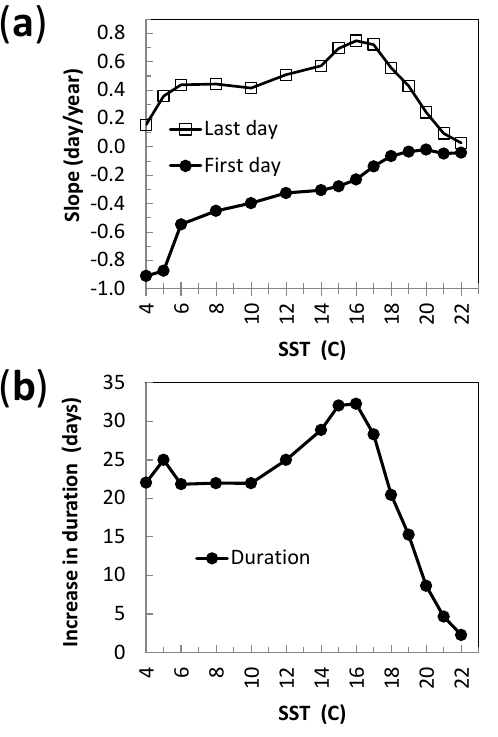
Figure 5. (a) Rate of change (dayyear − 1 ) in the day of year when a certain SST level is first reached (DFSST, filled circles) and when a certain SST level is last reached in a season (DLSST, open squares) for the Baltic Sea (area indicated in Fig. 1a). (b) Increase in the duration of a period with SST above a certain level (DDSST) from 1982 to 2014.